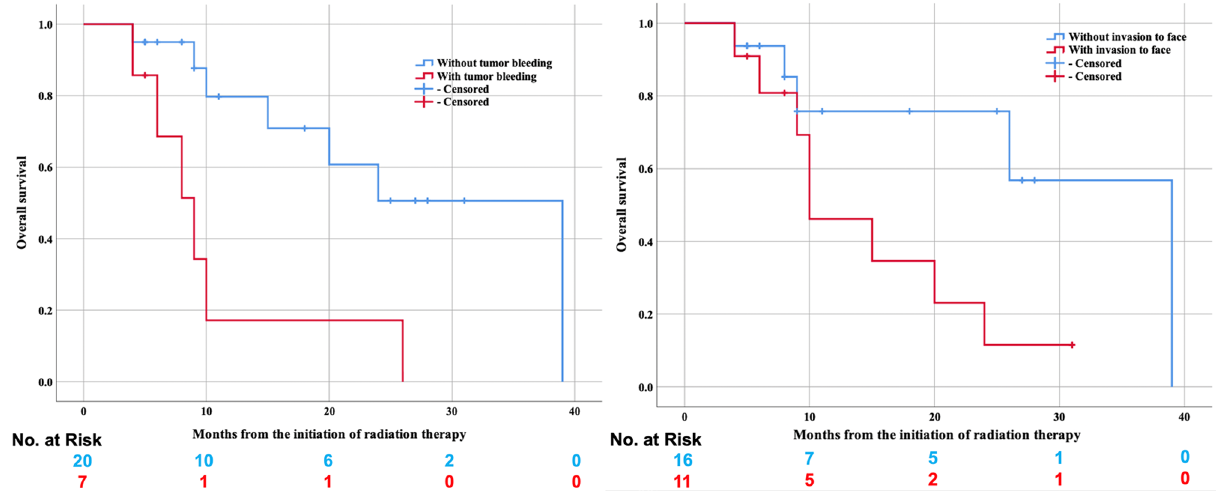
Figure 2. The Kaplan–Meier curves of OS* in accordance with tumor bleeding at the initiation of radiation therapy and tumor invasion to the face. OS*, overall